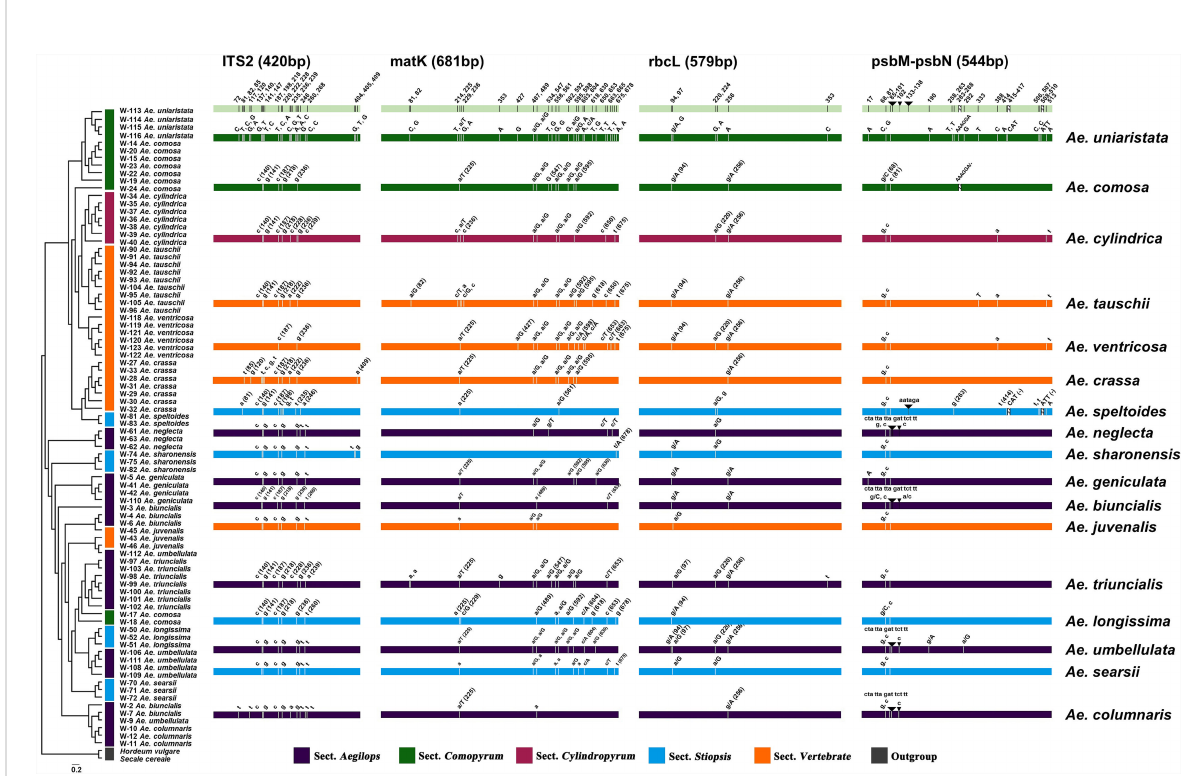
FIGURE 1 Differential distribution of four DNA barcode regions among 17 Aegilops species. Sections of species represented by different colors are described in the bar below. Uppercase and lowercase letters indicate the same and different nucleotides as the reference gene ( Ae. uniaristata ), respectively. The numbers in parentheses indicate the position of the DNA barcode